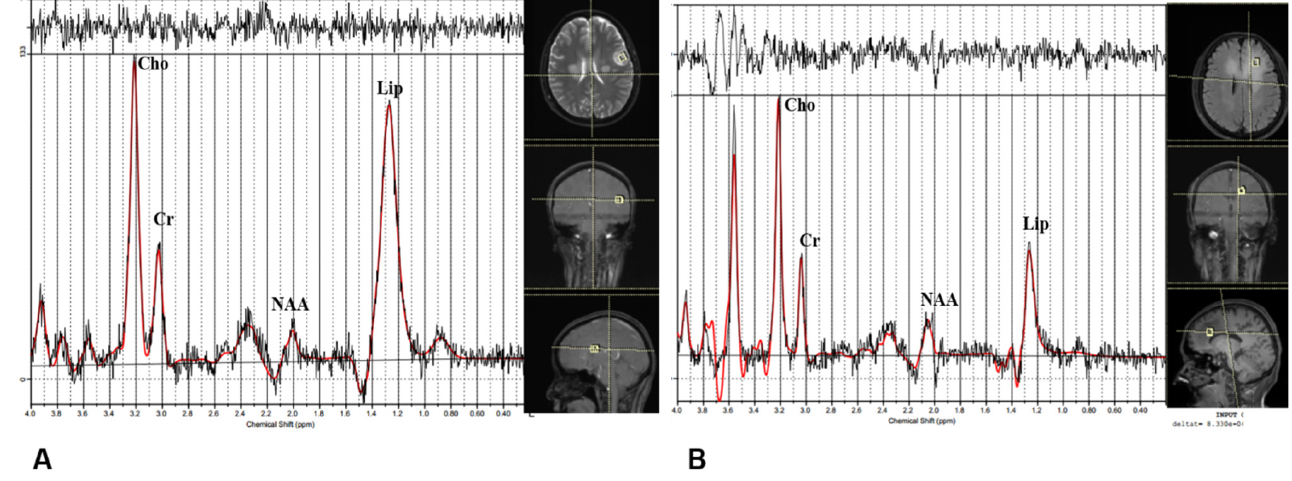
Figure 4. Illustrative results of analysis of magnetic resonance spectroscopy data. ( A ) A patient from subgroup 1. ( B ) A patient from subgroup 2.